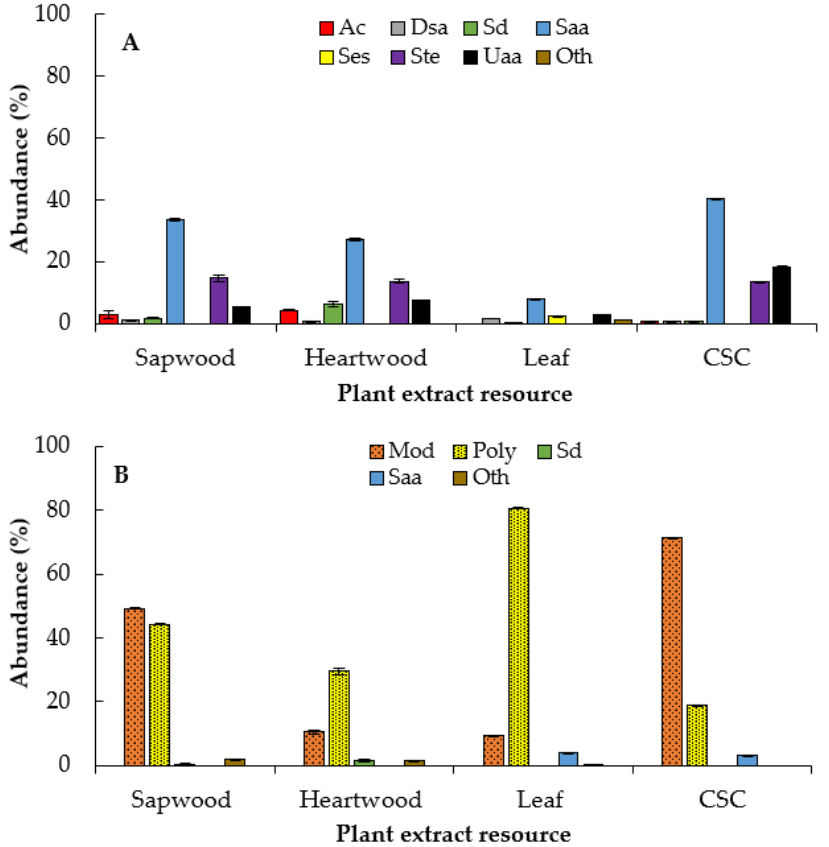
Figure 5. Chemical groups of E. platycarpa extracts, summarized by plant extract source. ( A ) Dichloromethane extract; ( B ) methanolic extract. Ac: aromatic compounds; Dsa: derivatives from saturated alkanoic acids; Mod: mono and disaccharides; Poly: polyols; Sd: saturated diacids; Saa: saturated alkanoic acids; Ses: sesquiterpenoids; Ste: steroids; Uaa: unsaturated alkanoic acids; Oth: others. CSC: Cell suspension cultures. Values represent the mean ± standard deviation of two replicates.